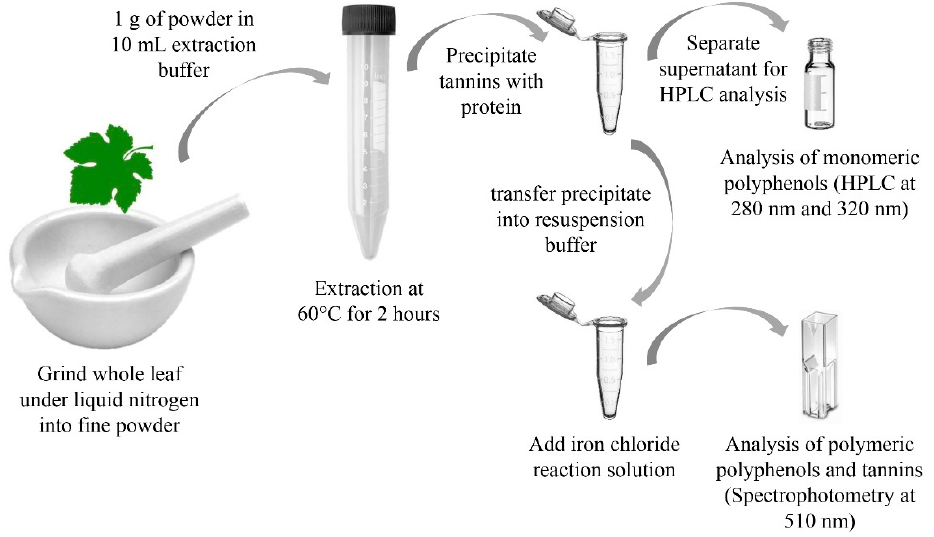
Figure 2. Spectrophotometric analysis of iron-reactive protein-precipitable phenolics in leaf tissue extracts over time. Extracts are shown for four cultivars using di ff erent temperature − solvent